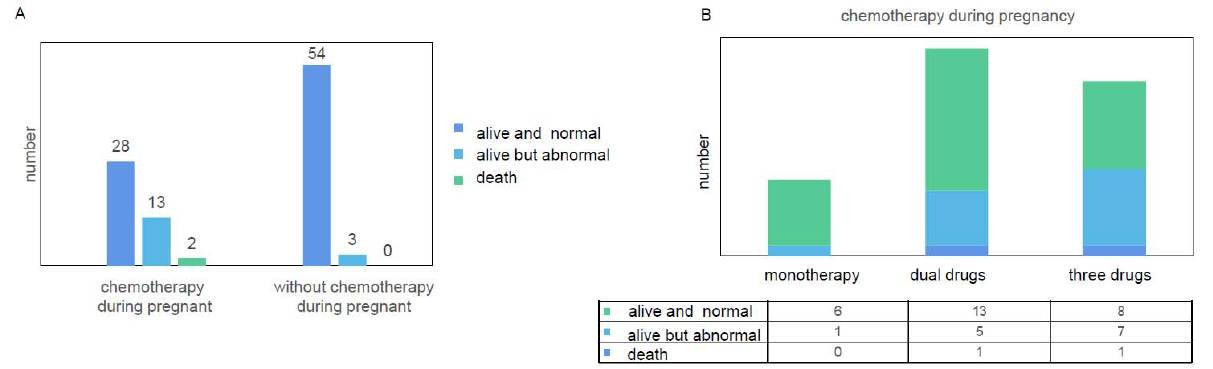
Figure 3. ( A ) Fetal outcomes in patients during pregnancy exposed to chemotherapy or not exposed to chemotherapy. ( B ) Fetal outcomes in pregnant patients with ovarian malignancy receiving different chemotherapy regimens.